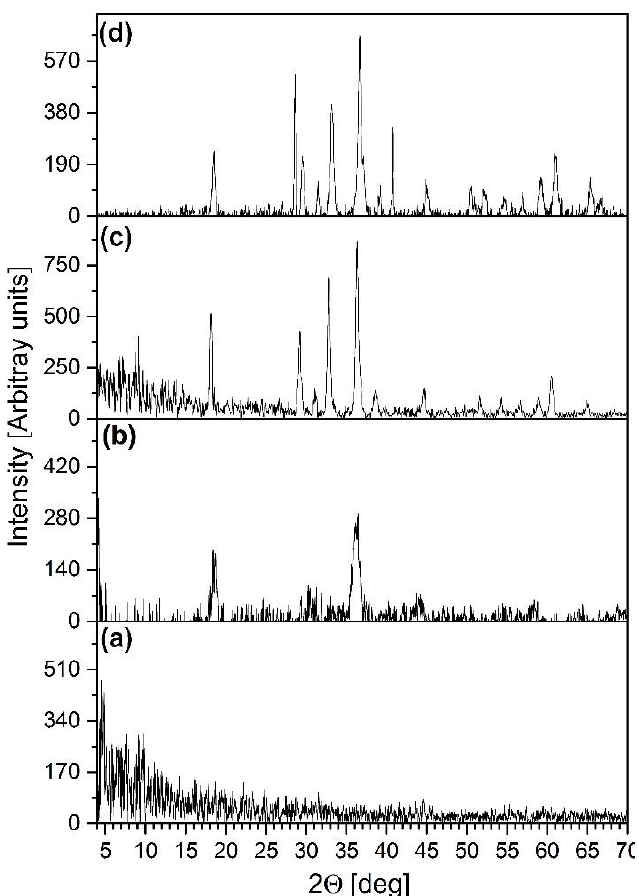
Figure 12. The powder X − ray diffractograms of the decomposition intermediates and products of compound 1 : ( a ) made by heat treatment in toluene at 110 °C, ( b ) made by the heat treatment of compound 1 at 500 °C in air and ( c ) made from the water − insoluble part of the decomposition inter- mediate of compound 1 made in toluene by heating at 500 °C and ( d ) made from the decomposition intermediate of compound 1 made in toluene by heating at 500 °C.